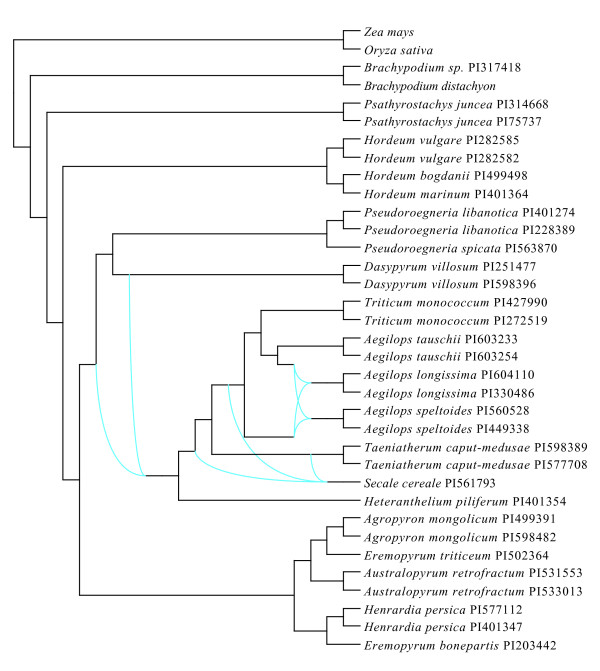
Multigenic network of Triticeae. Network obtained from the 27 individual gene trees modified with PhySIC_IST [56] using a correction threshold of 0.9 (see details in Methods).